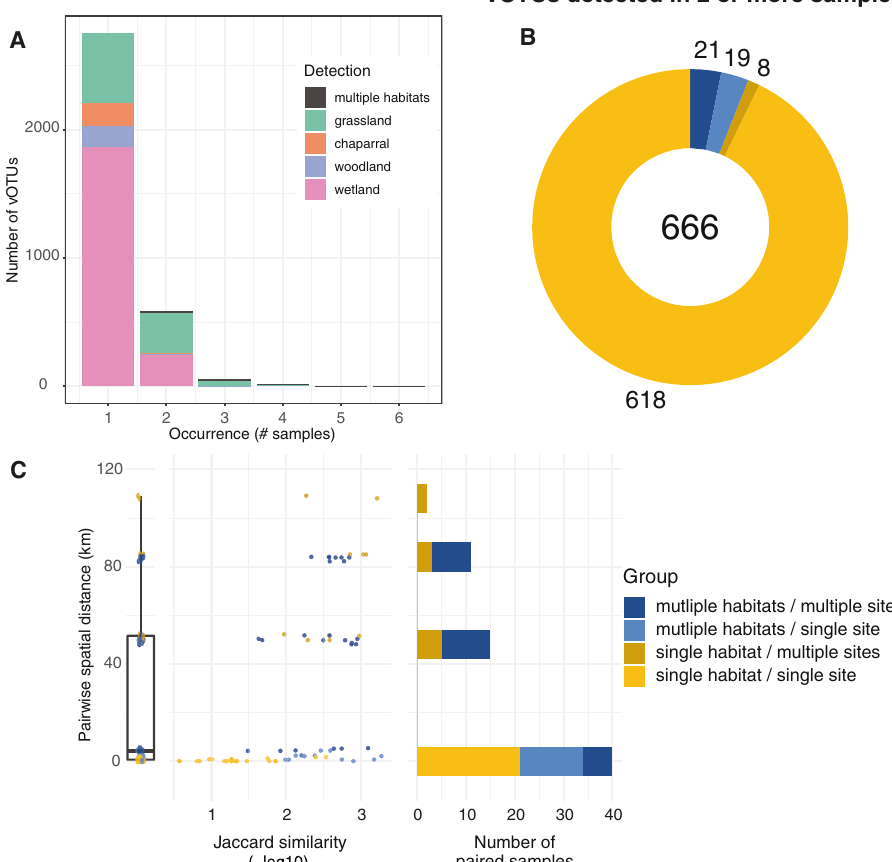
of vOTUs exhibiting a given detection pattern (y-axis), with stacked bar colors indicating the habitat(s) in which each vOTU was detected, ( B ) vOTUs detected in more than one virome, colored by their detection patterns across sites and habitats (legend to the right of panel C), numbers indicate total vOTUs (center) and vOTUs per detection pattern, and ( C ) Pairwise community compositional similarity (x-axis) by geographic distance (y-axis) between viromes, colored according to detection patterns across habitats and sites (legend on the far right). Left graph: box plot of pairwise distances for all viromes (condensed x-axis). Middle graph: Each point represents the -log10 Jaccard similarity between two viromes along the x-axis, with lower values (left side of the x-axis) indicating greater viral community similarity. Right graph: Total number of virome pairs included at each geographic distance. Paired viromes were only included if they shared at least one